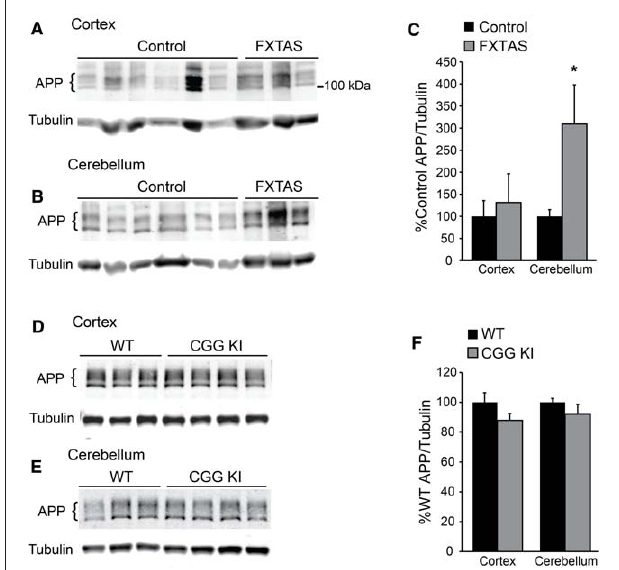
FIGURE 5 | Amyloid precursor protein expression in FXTAS patients and mouse models. (A) Frontal cortex lysates from control ( n = 10) and FXTAS patients ( n = 3) probed with a C-terminal α APP antibody which detects the three primary isoforms of full-length APP (100–125 kDa). (B) Cerebellar lysates from the same individuals as in (A) . (C) Normalized APP expression relative to tubulin expressed as a percent of controls, performed in technical triplicate. (D) Twelve-month-old CGG KI ( n = 4) and WT littermate control ( n = 3) cortex and subcortical lysates probed with α APP. (E) Cerebellar lysates from the same animals as in (D) . (F) Normalized APP expression in CGG KI mice expressed as a percent of WT controls, performed in technical triplicate. * P < 0.05 Student’s t